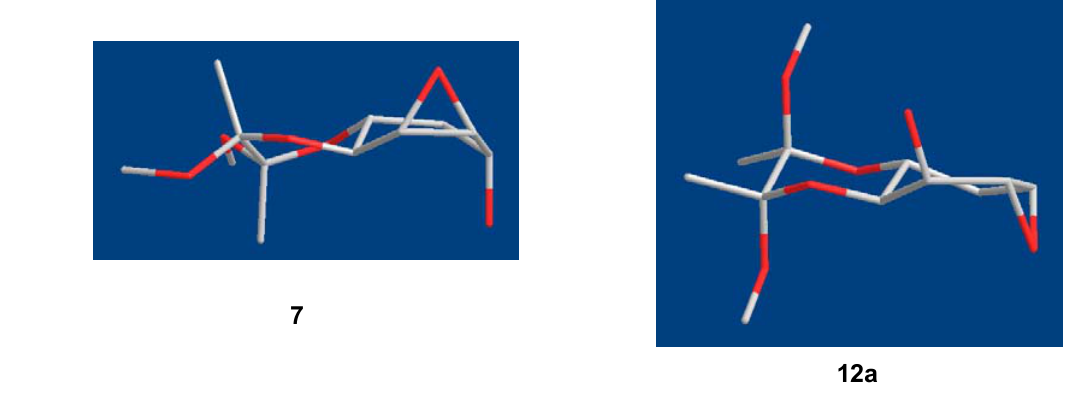
Figure 4. Three-dimensional representations of structures 7 and 12a